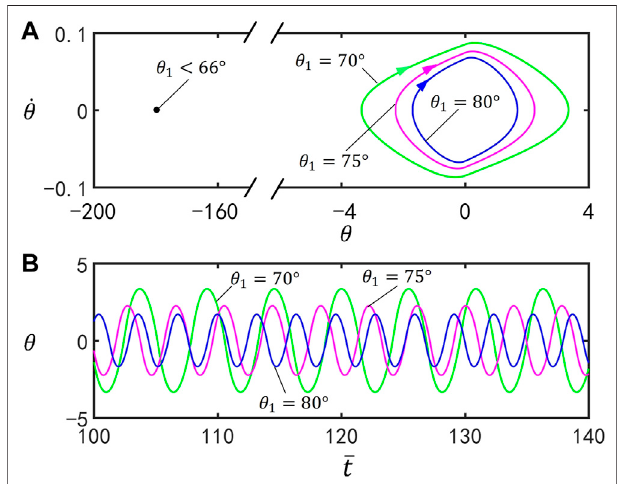
FIGURE 4 | Effect of the vertex angle on self-stabilized oscillation of the inverted pendulum for (cid:2) I (cid:2) 0 . 25, C 0 (cid:2) 0 . 4, (cid:2) g (cid:2) 9 . 8, (cid:2) ζ (cid:2) 14 . 7, θ 0 (cid:2) 0 ° , and _ θ (cid:2) 0. (A) Limitcyclesfor θ 0 θ